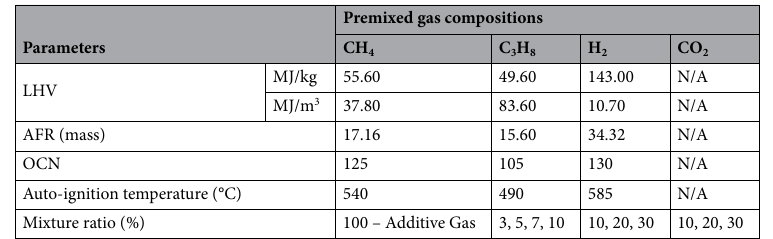
Table 3. Specification of premixed gas compositions at standard states 39